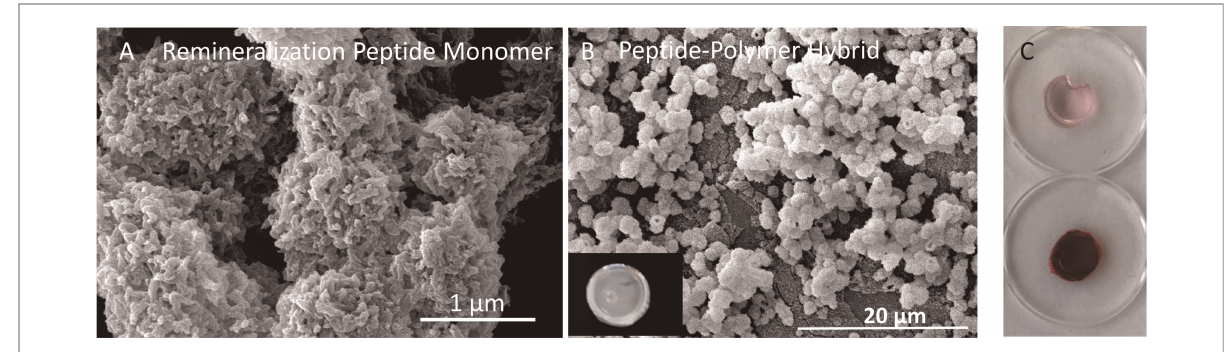
FIGURE 5 ( A ) SEM images of the minerals formed in the presence of K-GSGGG-HABP monomer; ( B ) K-HABP:AMPM7 integrated polymer disc samples was monitored under SEM after completing the overnight mineralization reaction; ( C ) peptide integrated polymer discs after mineralization were stained with alizarin red. The same type of discs without mineralization were used as